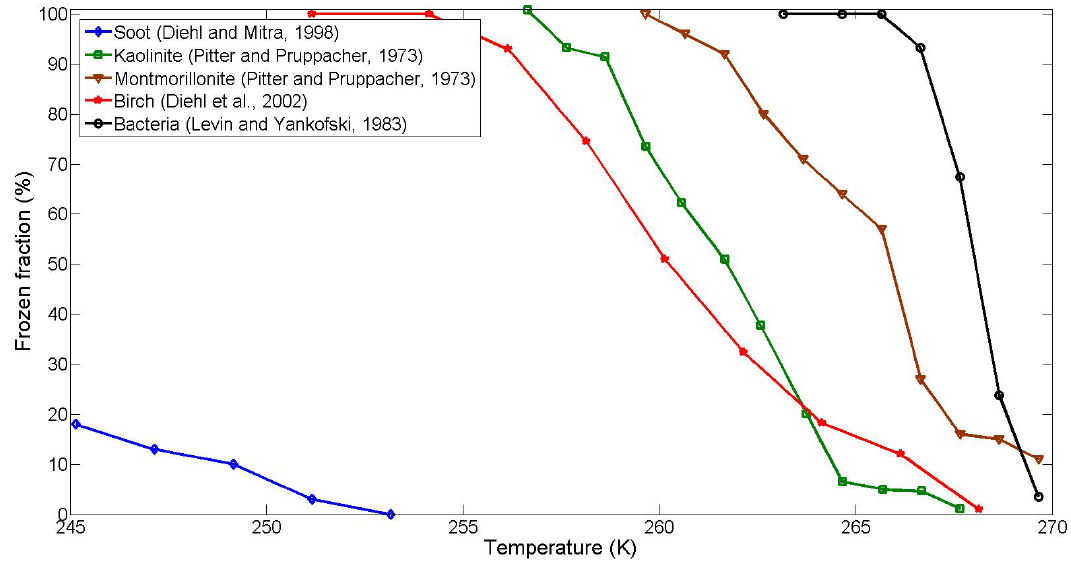
Fig. 7. Comparison of different contact freezing experiments conducted in a wind tunnel. Blue represents the experiments done with soot particles, green with kaolinite, brown with montmorillonite, red with pollen and black with bacteria (Pitter and Pruppacher, 1973; Levin and Yankofsky, 1983; Diehl and Mitra, 1998; Diehl et al.,